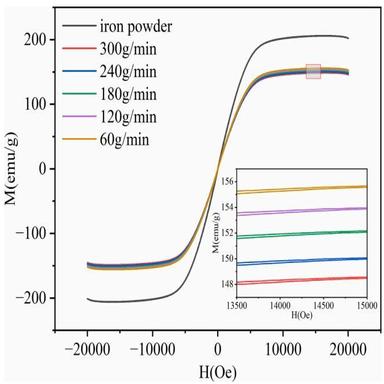
The hysteresis line diagram of cBN-MAPs.